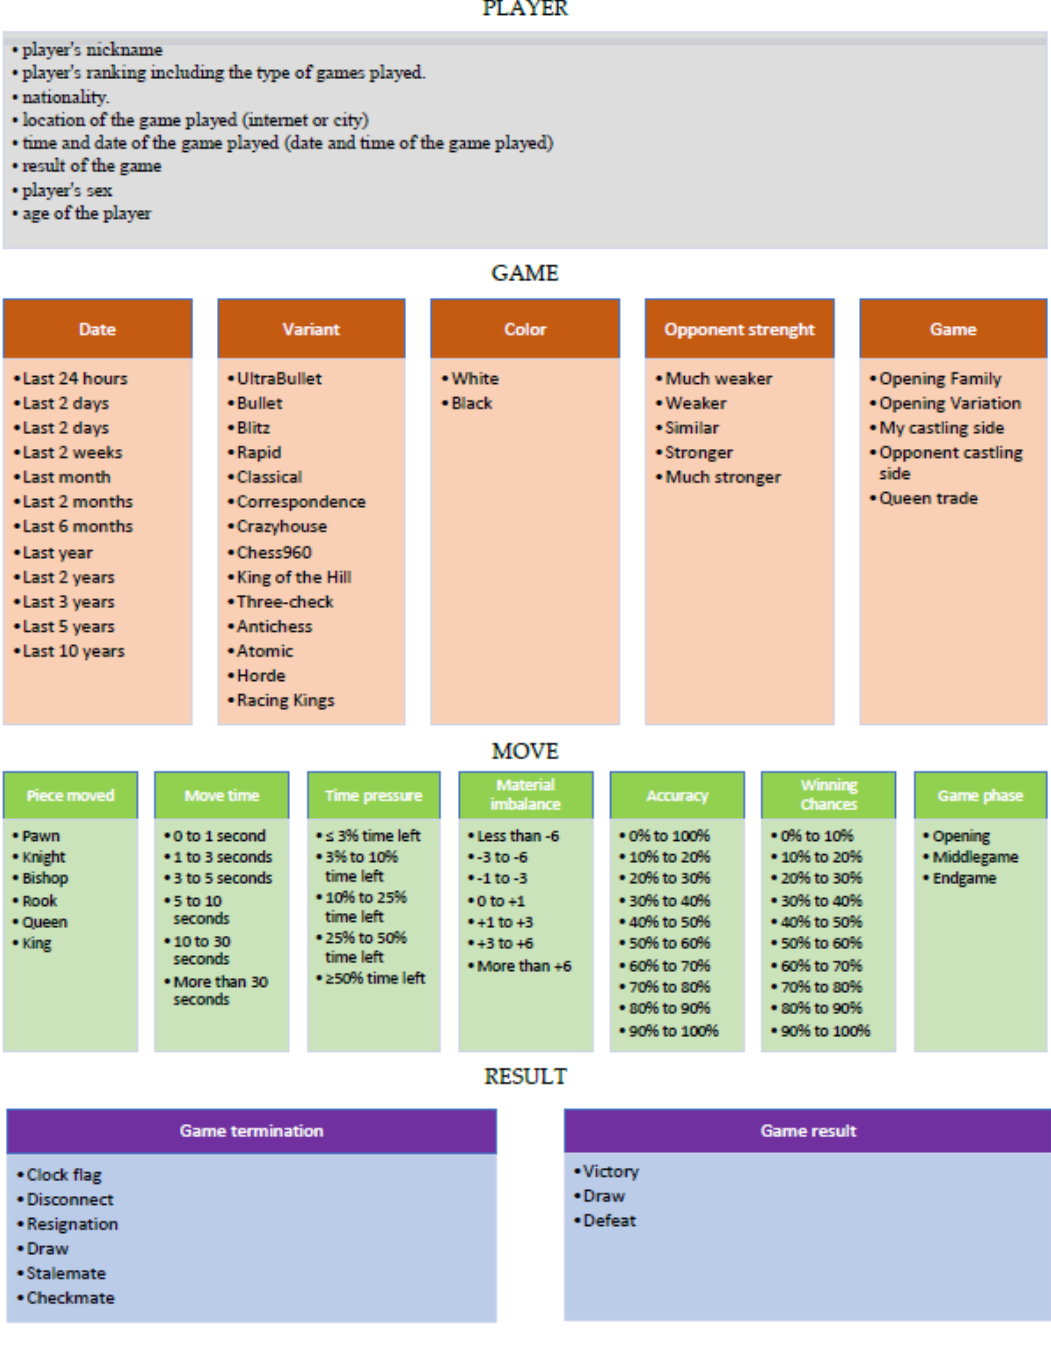
Figure 1. Information retrievable from online chess databases. Source: own study.